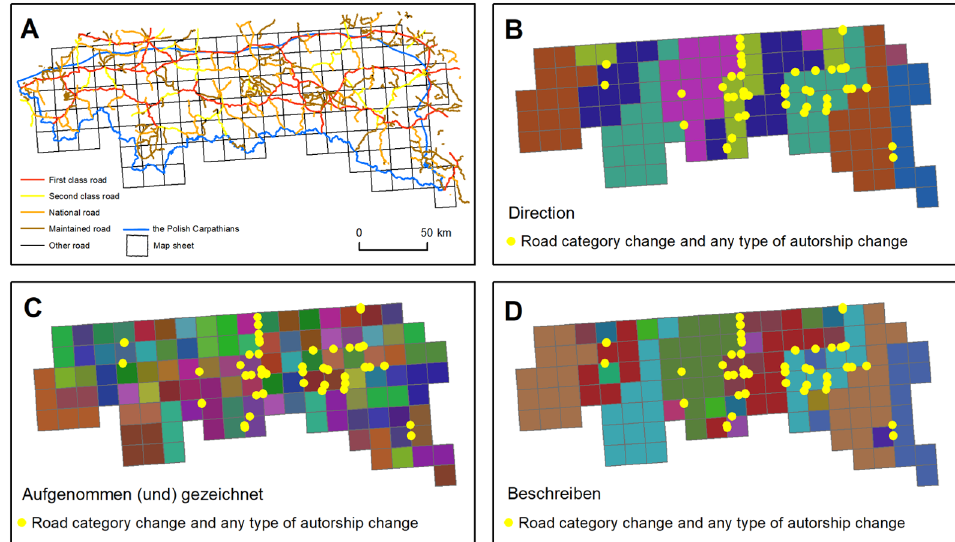
Fig. 6. Changes in road category on map sheet boundaries: study area (A), changes in regard to director change (B), changes in regard to drafter change (C), changes in regard to description writer change (D). Note: road category change locations on maps B–D are the same; only the authorship